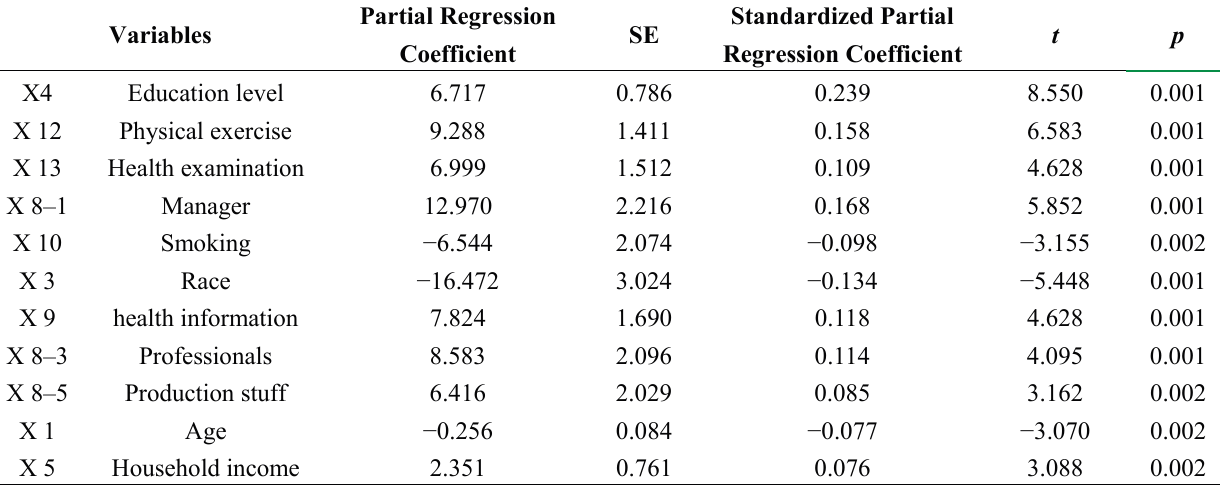
Table 3. Multiple linear regression analysis about health literacy with sociodemographic characteristics, health behavior, health